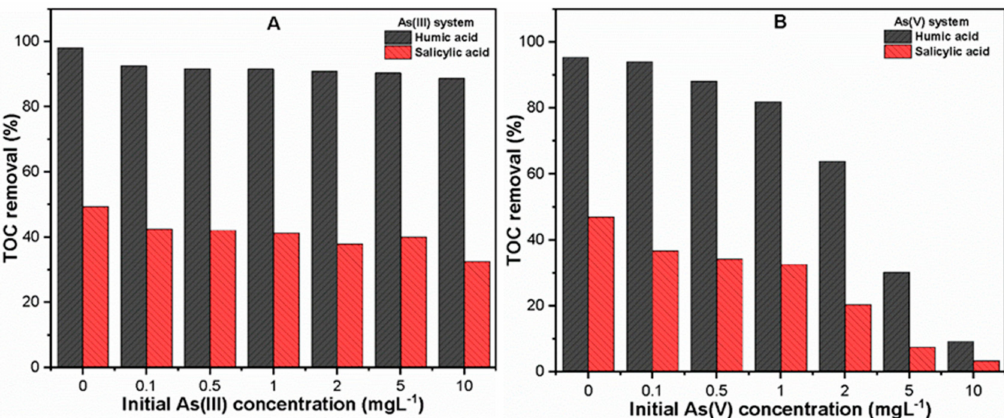
Figure 5. Under various initial As(III, V) concentrations (0–10 mgL − 1 ), TOC removal in ( A ) As(III) and ( B ) As(V) system in the presence of 10 mg L − 1 organic ligands (HA / SA).